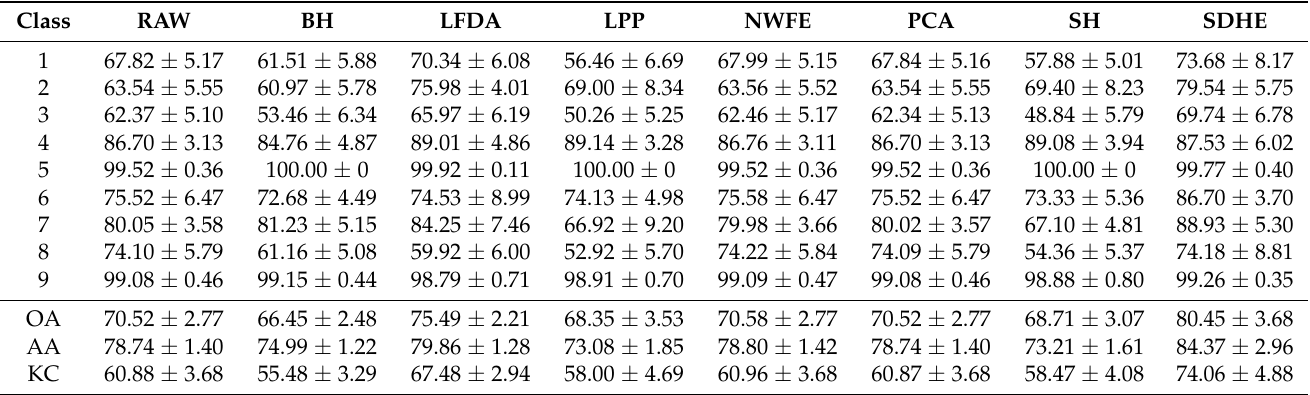
Table 4. Classification accuracy (%) at 30-dimensionality for Pavia University with the training set of 20 samples per class.